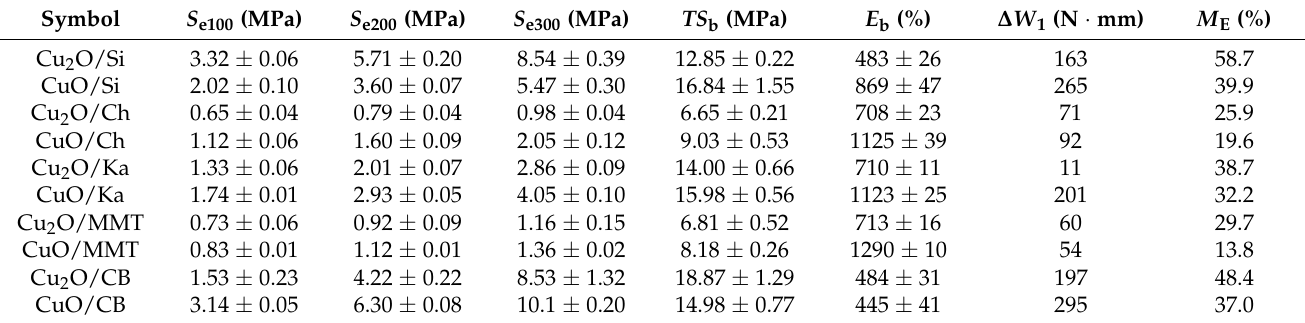
Table 4. Mechanical properties of filled CR vulcanizates; T = 160 ◦ C, t = 45